Question: Provide a publication-style caption for this figure.
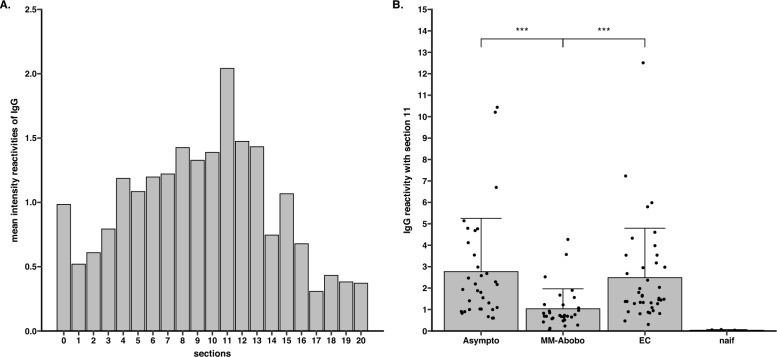
Answer: Patterns of brain self-reactive IgG responses in AS, MM & EC. A Distribution of mean intensity reactivities of IgG from AS, MM & EC recognized sections in brain extract. B IgG reactivity level against Sect. 11 in AS, EC, and MM groups. Asterisk indicates a significant difference in antibody reactivity level (* p < 0.05; ** p < 0.01; *** p < 0.001)